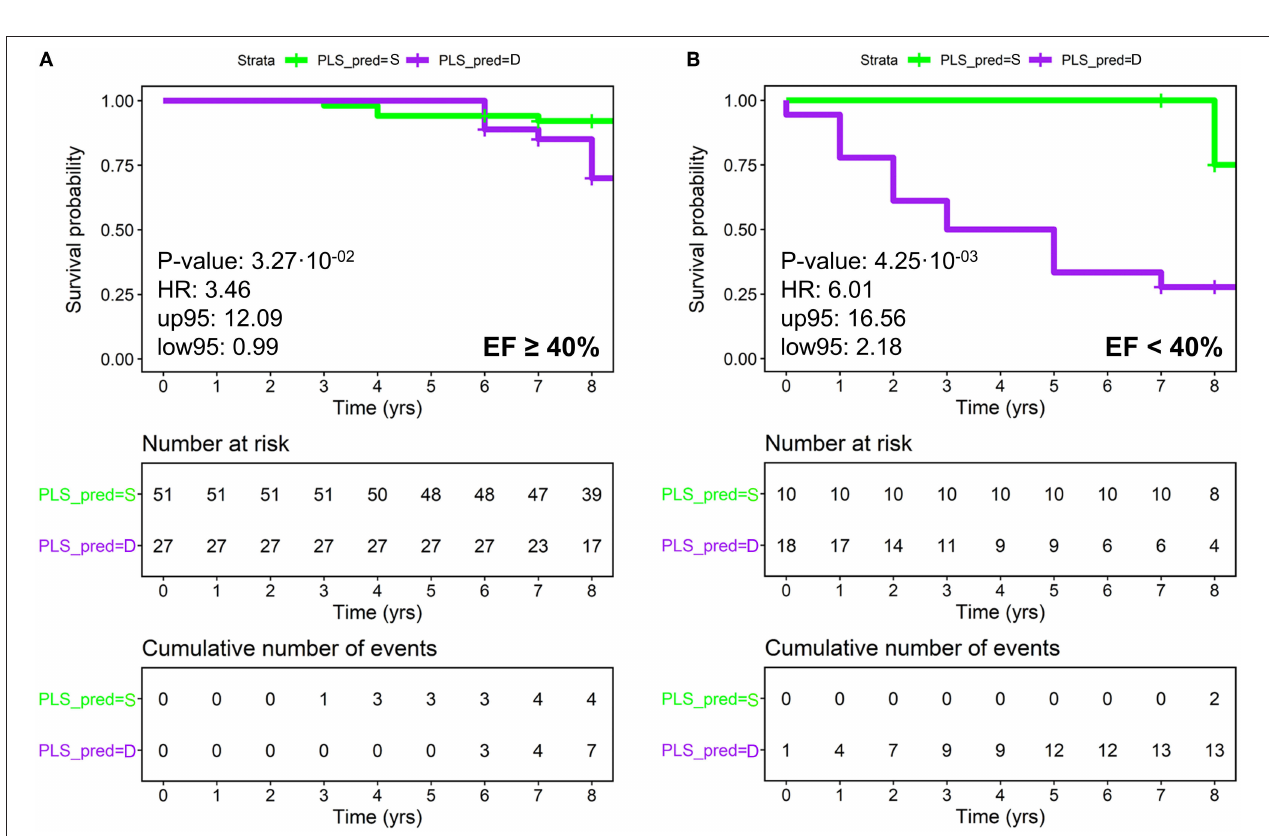
FIGURE 3 | Censored events represent either the time of last recorded clinical follow up, or time of death. Number at risk: number of patients stratified according to the left ventricular ejection fraction (LVEF) at each time point. Cumulative number of events: total number of deceased patients at each timepoint for each risk group based on the LVEF. The P -values are calculated with the Log-Rank test. EF_PRED = LR: predicted by EF at low risk of death; EF_PRED = IR: predicted by EF at intermediate risk; EF_PRED = HR: predicted by EF at high-risk.